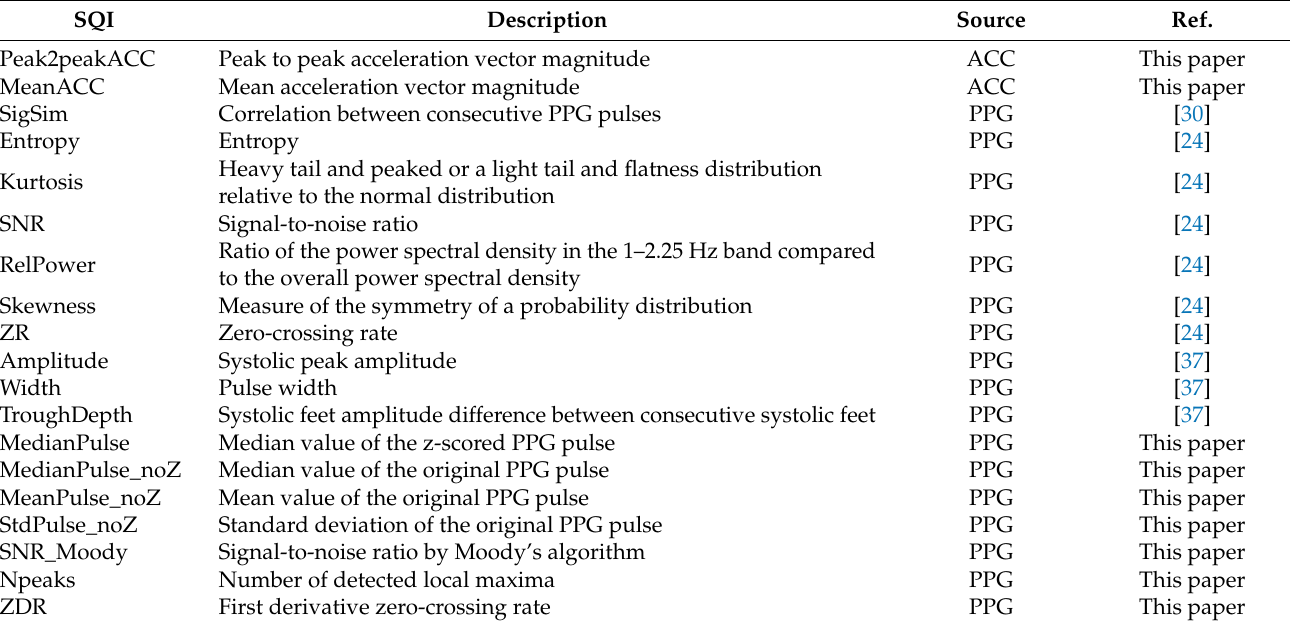
Table 2. Signal quality indices (SQIs) for quality